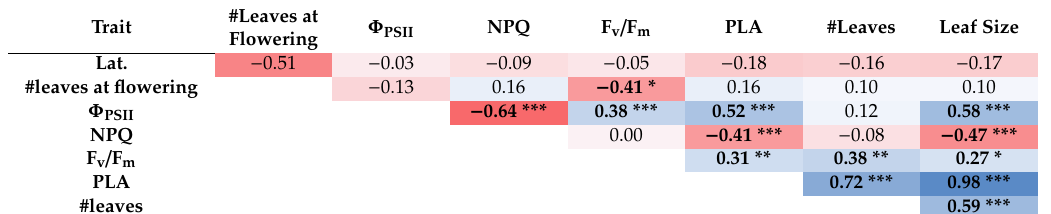
Table 2. Correlation matrix for traits observed in plants grown under uniform and fluctuating light. Blue colored backgrounds indicate a positive correlation, red indicates negative; the more strongly colored the background, the steeper the slope of the correlation. Statistically significant correlations ( p < 0.05) are marked in bold. Numbers indicate Spearman’s ρ , stars indicate the significance of the correlation, as: *** = p < 0.001, ** = p < 0.01 and * = p < 0.05 (n = 15–72). Lat., latitude of origin ( ◦ ), #leaves flowering, number of leaves at